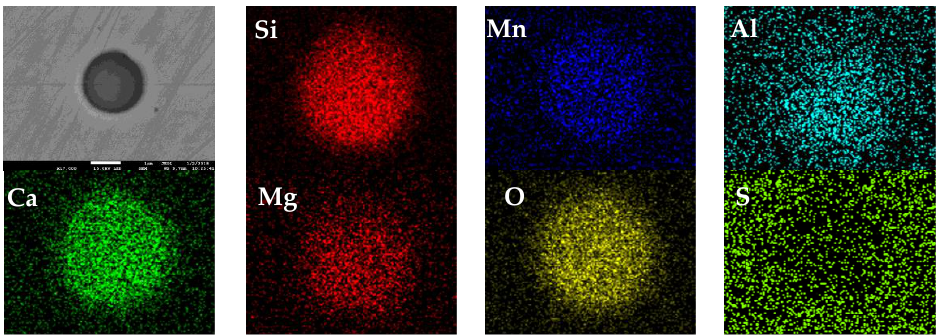
Figure 15. SEM mapping of typical inclusions in steel treated with synthetic refining slag containing Rb 2 O.